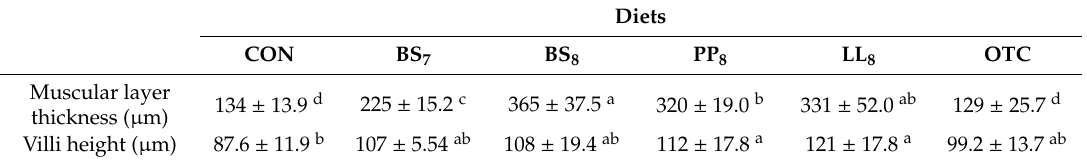
Table 6. Intestinal histology of juvenile whiteleg shrimp fed the different probiotics diets for 8 weeks 1 .